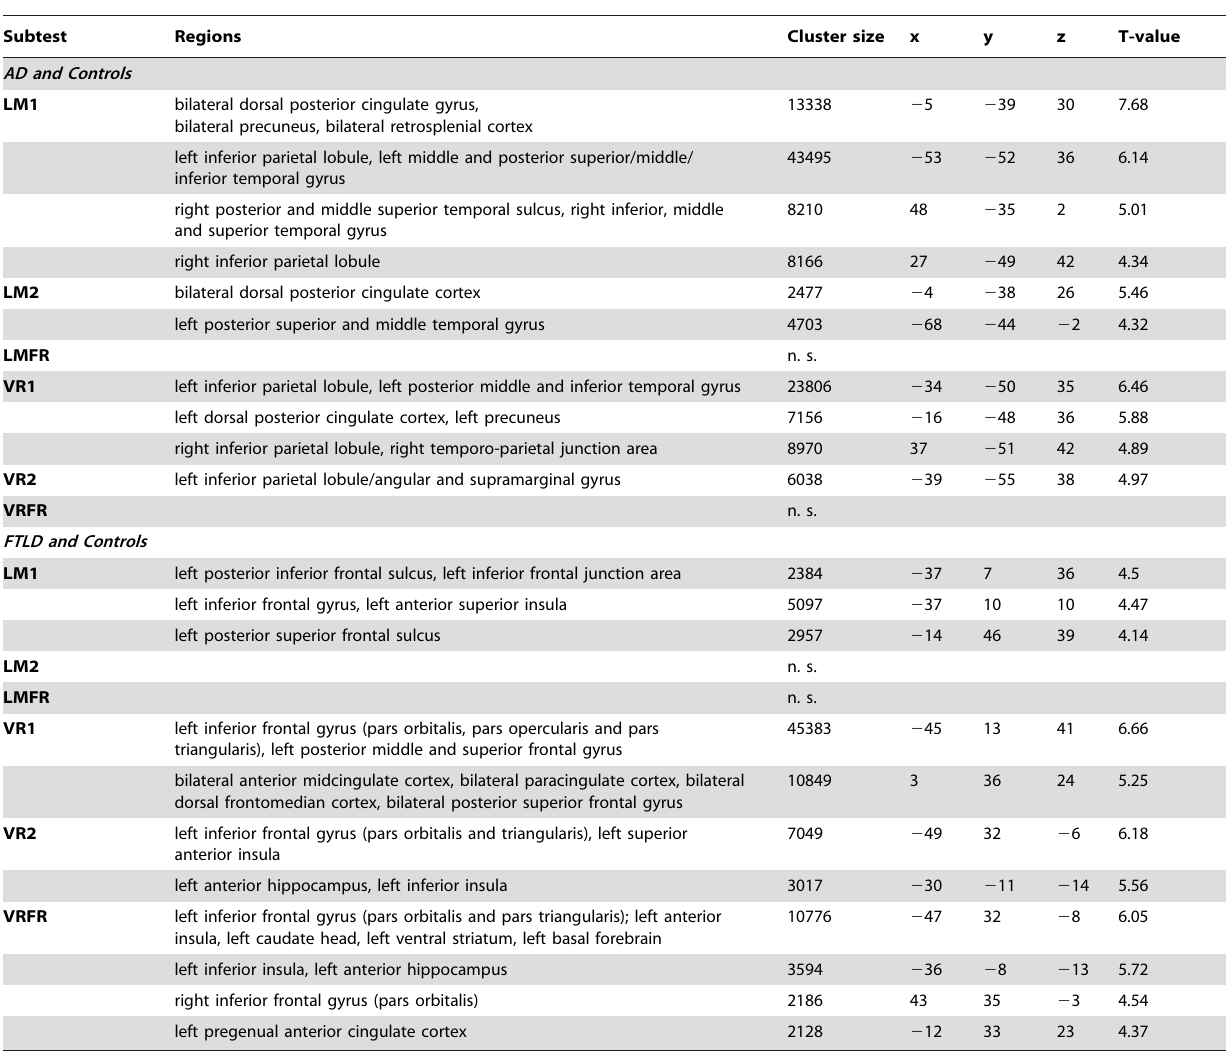
Table 3. Memory performance and hypometabolism.